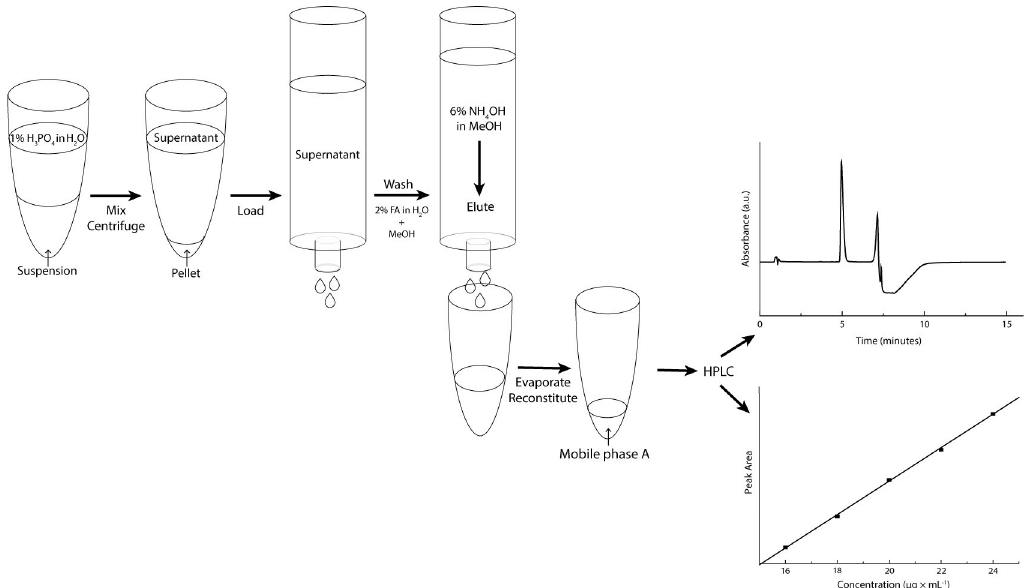
Fig 1. Schematic representation of clonidine hydrochloride sample preparation for analysis of oral liquids using HPLC-UV.